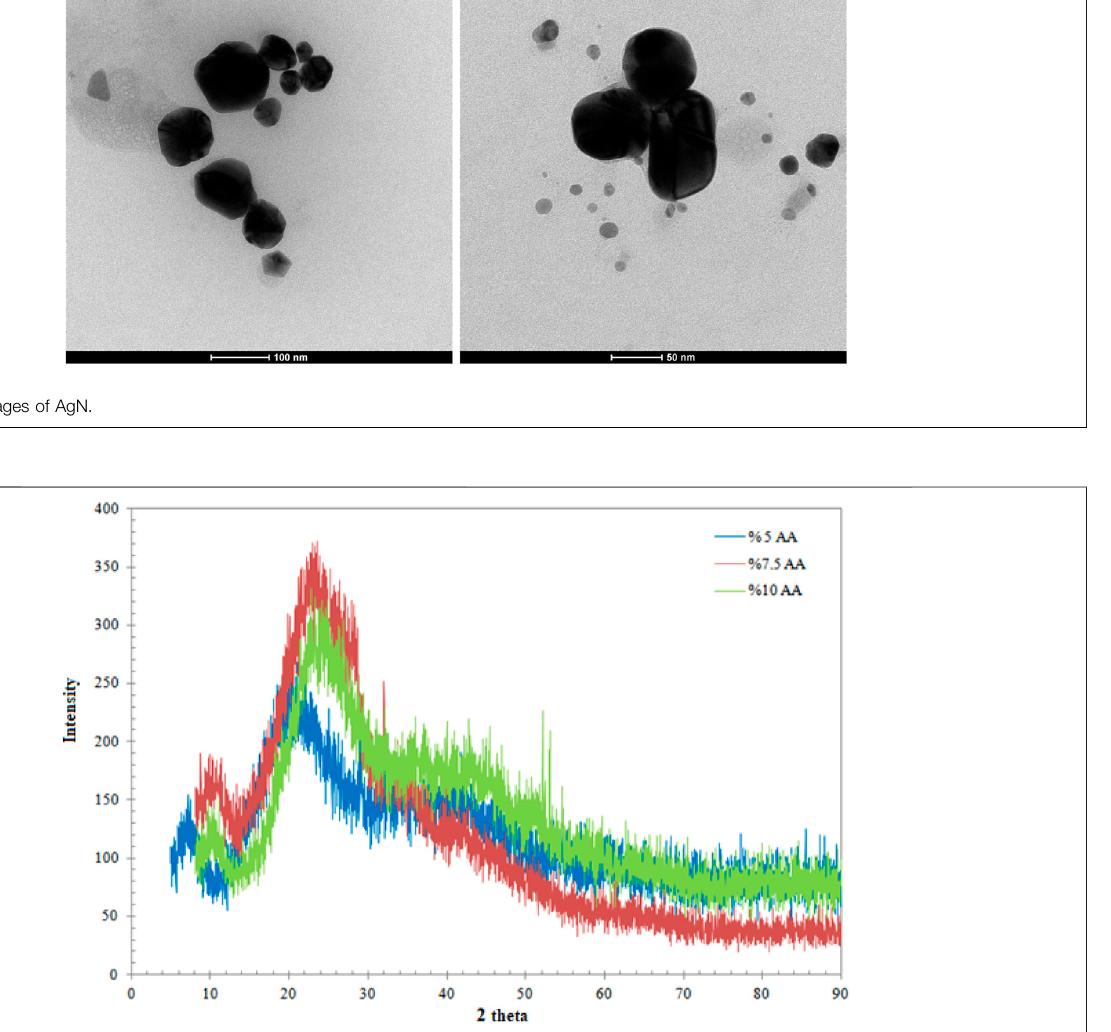
FIGURE 2 | XRD patterns of the fi